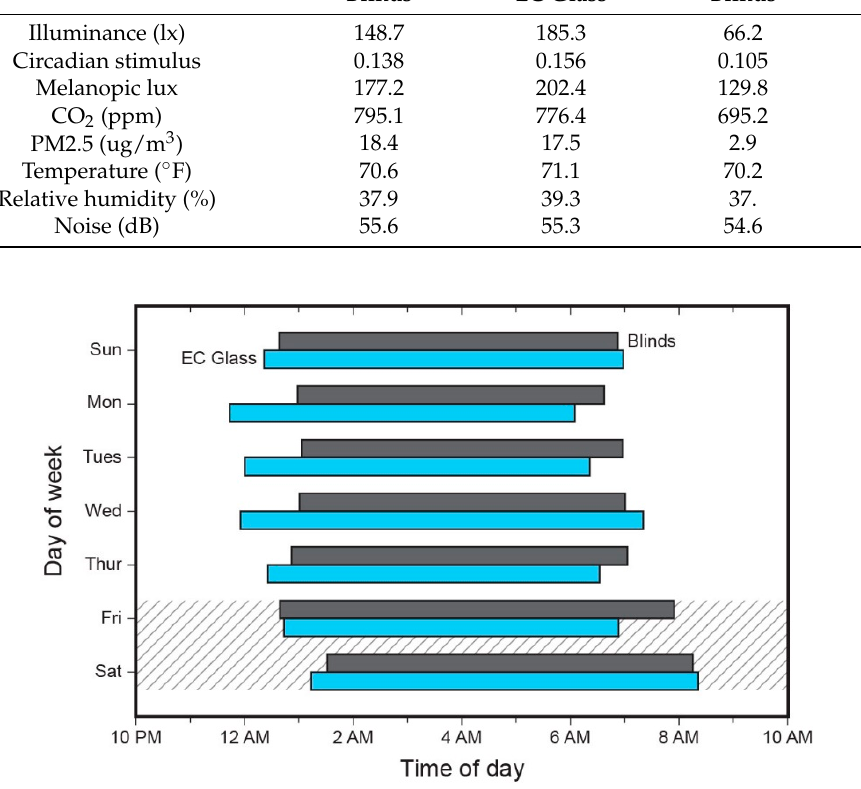
Figure 3. Actigraph-recorded mean sleep timing during intervention weeks, by day of week. The start of the bar (left) represents mean sleep onset time across the 20 participants, while the end of the bar (right) represents the mean wake time. The cross-hatched area represents weekend night sleep periods. Table 3. Results of the linear mixed effects model of intervention and weekday sleep onset timing.